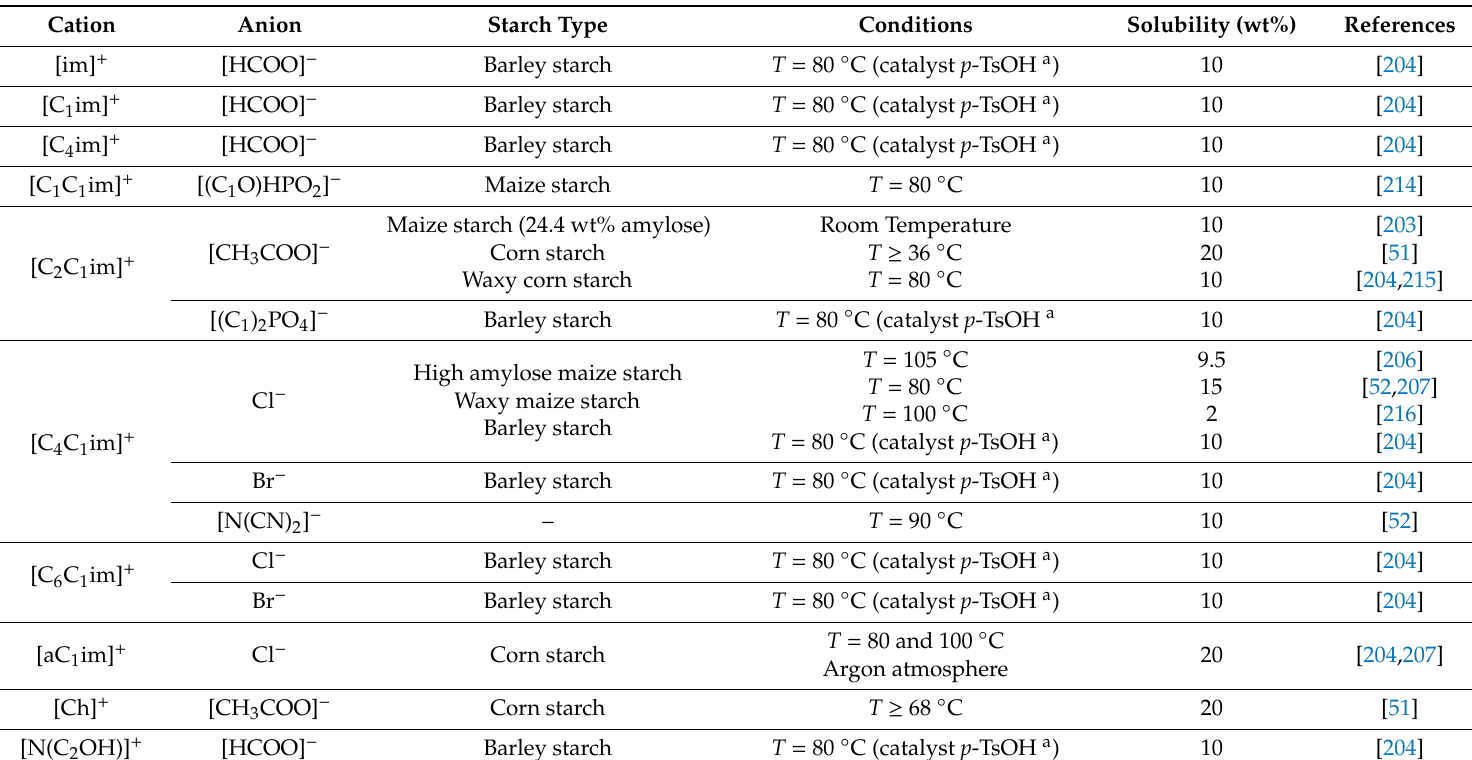
Table 6. ILs reported to dissolve starch, starch solubility and conditions